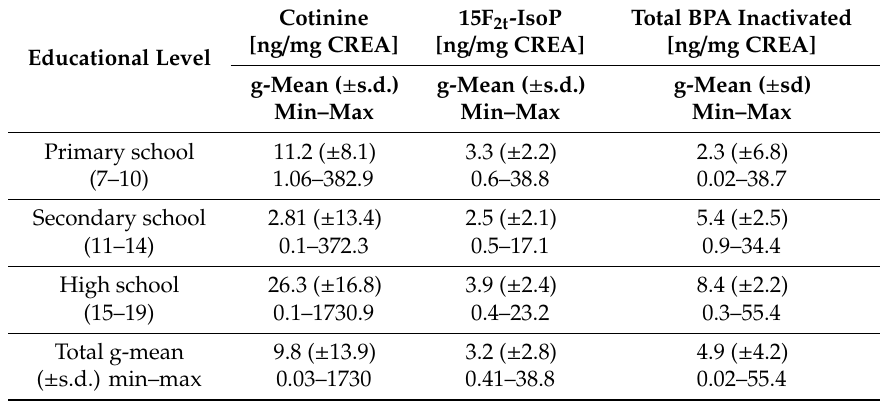
Table 2. Urinary cotinine, 15F2t-IsoP, and total BPA inactivated values in the three groups subgrouped according to the three educational level considered. g-Mean = geometric mean, s.d. = geometric standard deviation, Min = minimum value; Max = maximum value. Units of biological markers are nanograms of every 1 mg of urinary creatinine.